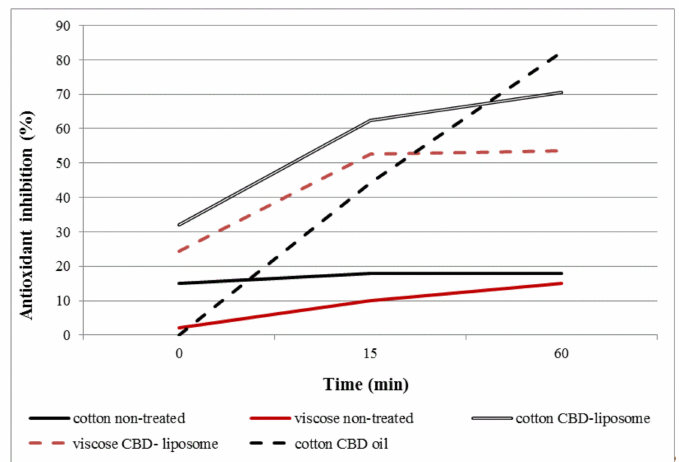
Figure 6. The antioxidant capacity (as inhibition %) of non-treated, CBD liposome, and CBD oil only functionalized cotton samples compared to non-treated and CBD liposome functionalized viscose